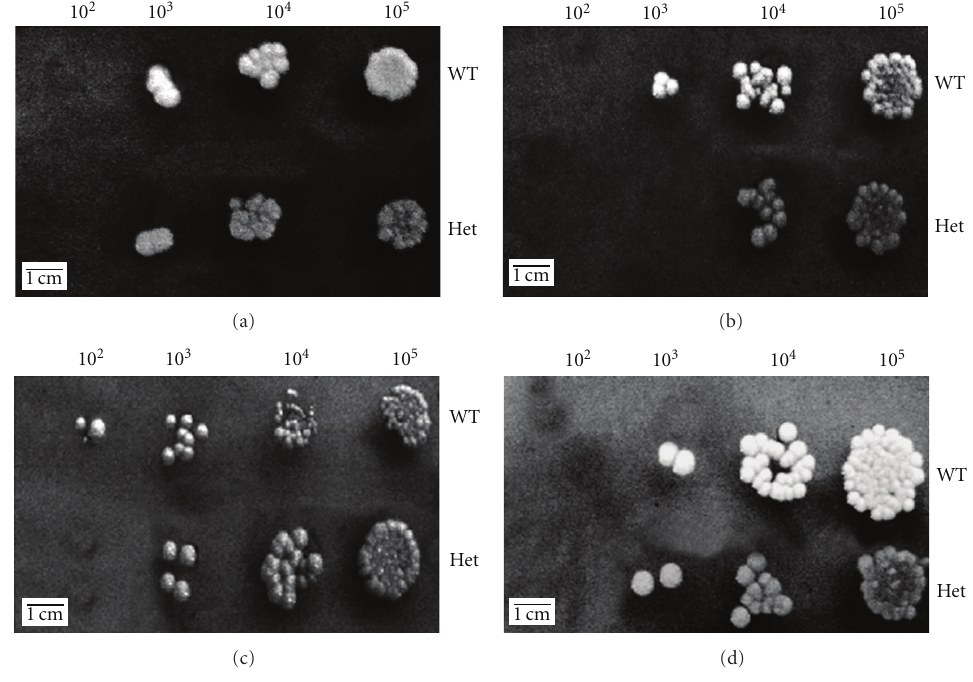
Figure 7: Cell surface disrupting agents. (a) Control plate; (b) 12.5 μ g/mL calcofluor white; (c) 0.0225% SDS; (d) 50 μ g/mL Congo red. Strains were grown in PDB, then diluted (10 5 to 10 2 cells/mL), and spotted on PDA plates containing di ff erent concentrations of cell surface disrupting agents. A slight increase in susceptibility to SDS and calcofluor white was